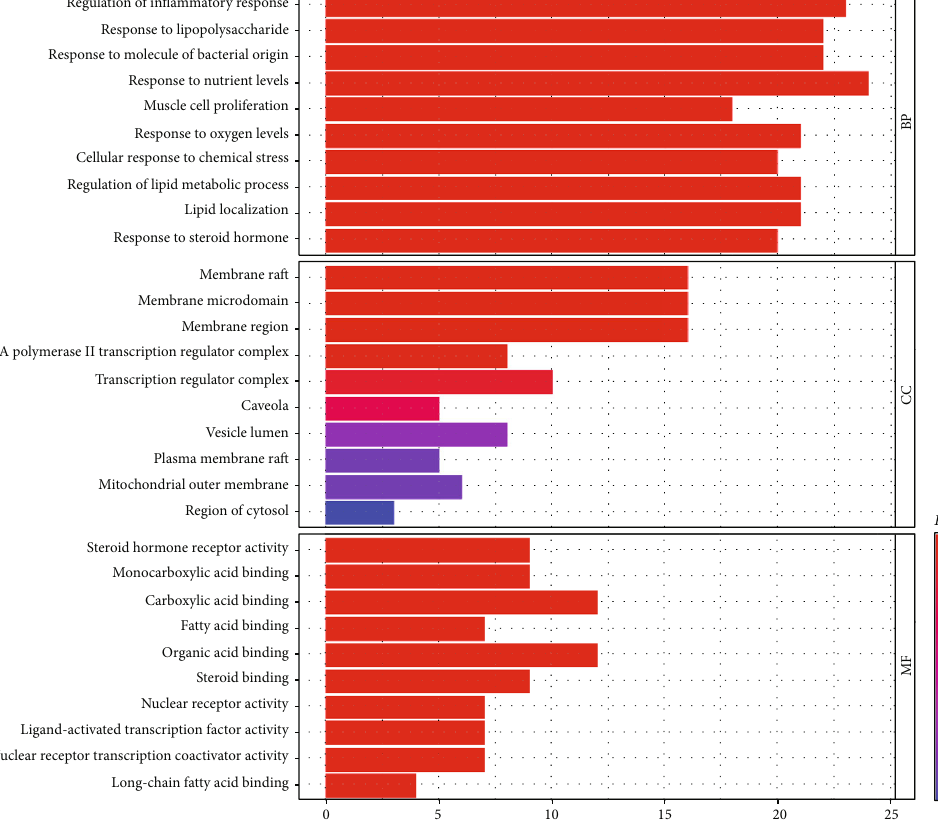
Figure 6: Enriched GO terms for BP, MF, and CC of putative targets of active components of Cordyceps. The color of the bar is displayed in a gradient from red to blue according to the ascending order of the P value, while the length of the bar is arranged according to the ascending order of the number of gene